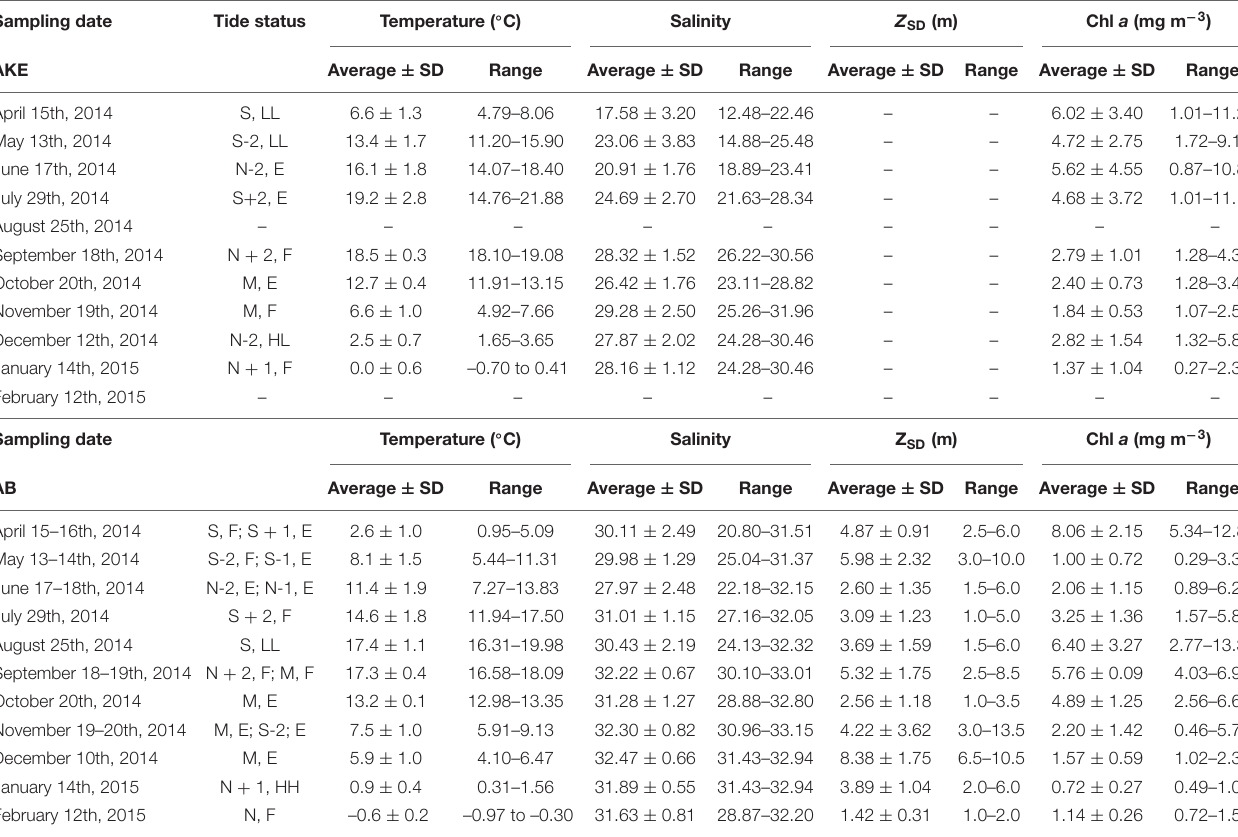
TABLE 1 | Summary of temperature, salinity, and Chl a concentration at the surface and Secchi disk depth ( Z SD ) during sampling cruises.